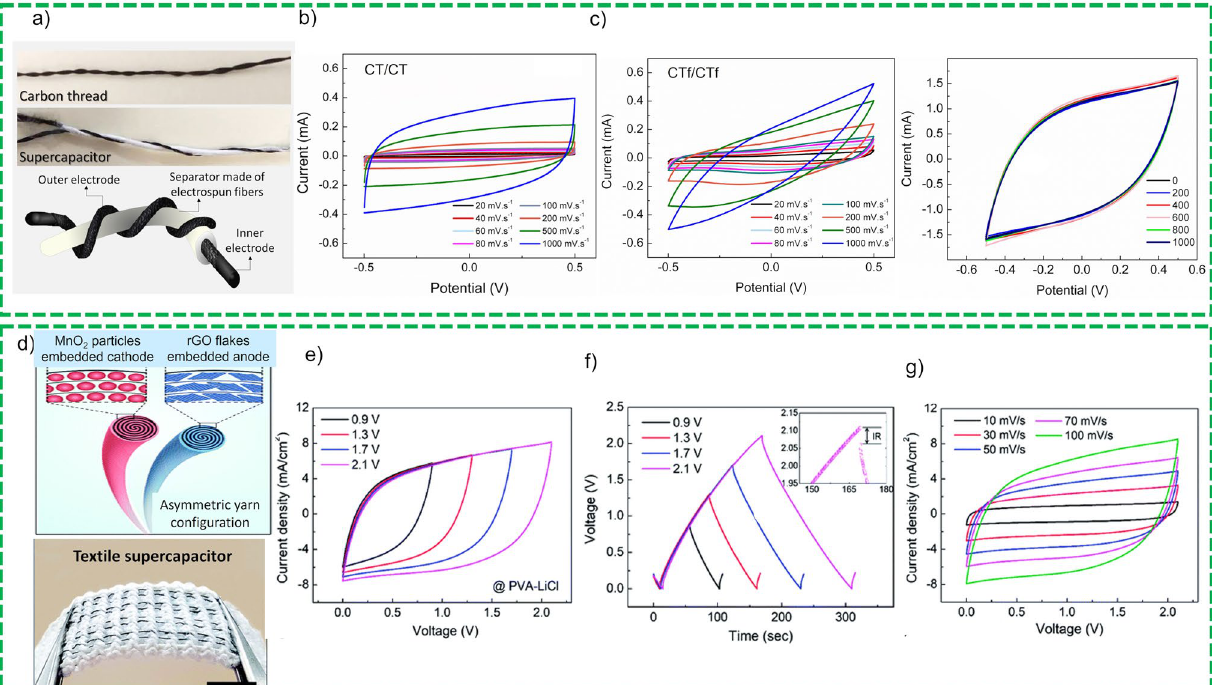
Fig. 14 a Pictorial representation of the device in twisted configuration of carbon thread, b and c electrochemical performance comparison of pristine carbon fibers and polypyrrole functionalized carbon fibers at different scan rate, Reprinted with permission from Ref. [125], d schematic demonstration of asymmetric supercapacitors, e electrochemical performance in different potential windows and comparison of cyclic voltam- mograms on different scan rates, f charge and discharge comparison of the device at different potentials, g CV comparison at different scan rates. Reprinted with permission from Ref.